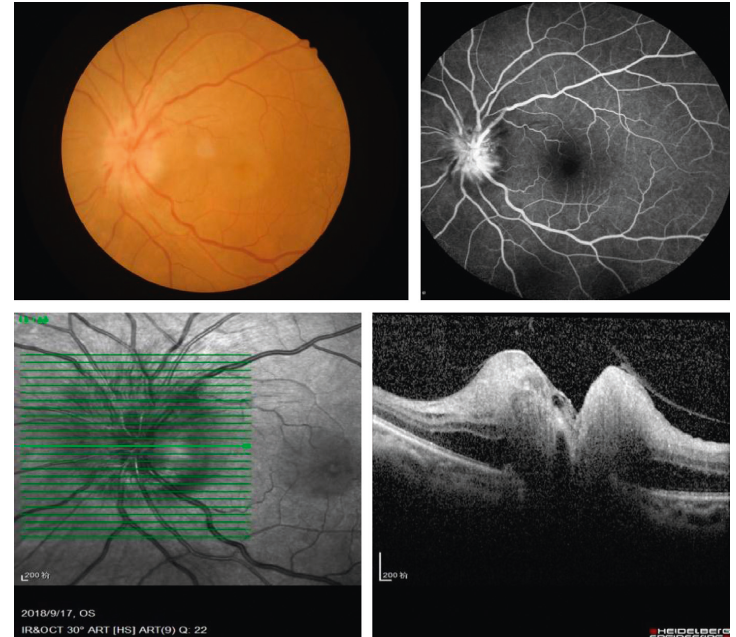
Figure 1: Fundus imaging. FFA and OCT showed the swollen optic disc and optic papilla surface fluorescence